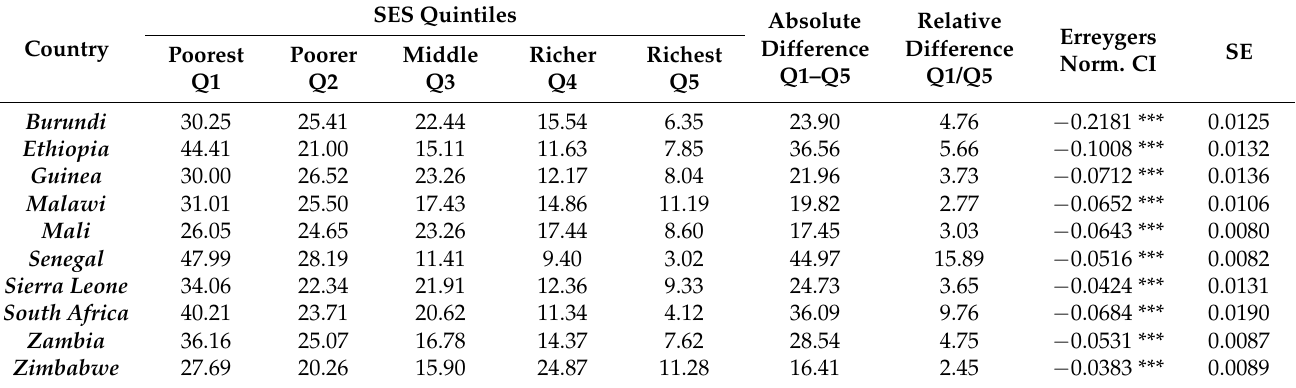
*** indicate statistical significance at